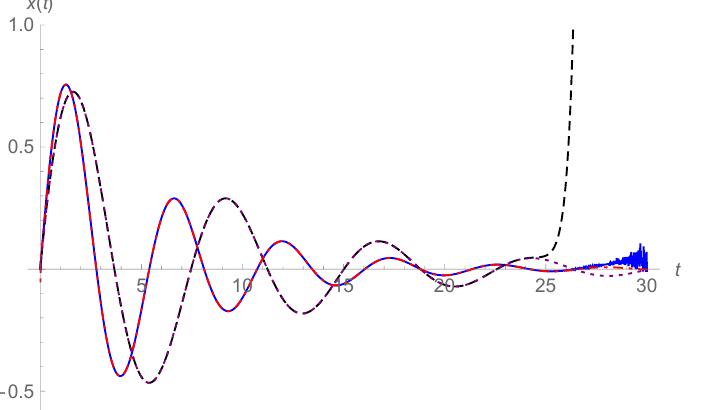
Figure 9. Curves of x ( t ) for m = k = 1, c = 0.5 and for α = 0.5 (solid and dotted-dashed lines) and 1.5 (dashed and dotted lines), where solid and dashed lines are from Equation (17), dotted-dashed and dotted lines from Equation (45).